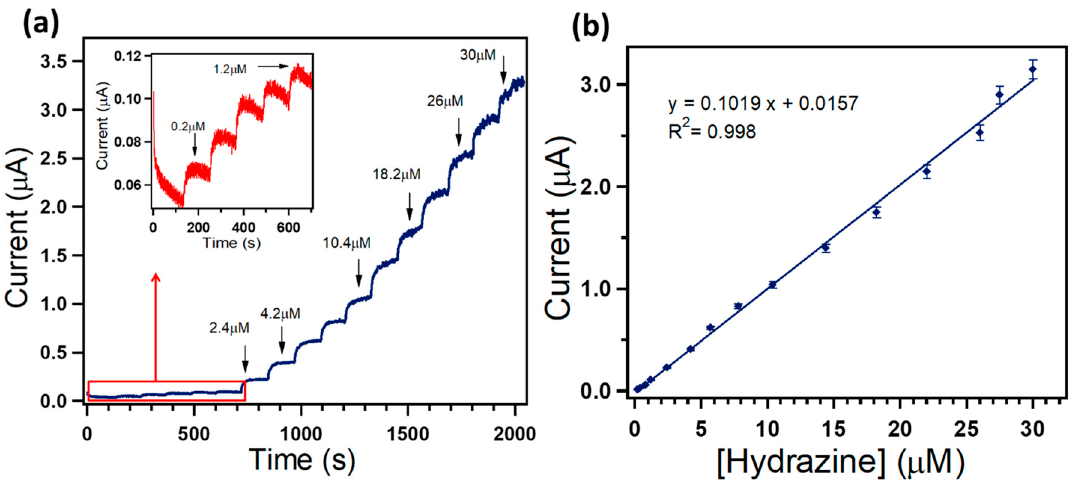
Figure 5. ( a ) Current–time (i–t) response of Fe-doped TiO 2 modified GCE for 0.2–30 μ M hydrazine concentrations at a constant potential +0.45V vs. Ag/AgCl. Inset shows an enlarged part of the early stage addition (0.2–1.2 μ M). ( b ) The corresponding current–concentration calibration graph. It has been proposed that hydrazine in slightly basic medium (pH = 7.4) is oxidized onto the